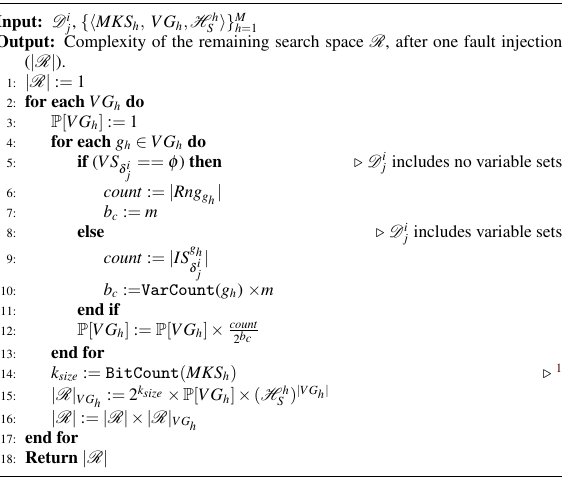
Algorithm 3 Procedure EVAL_ SEARCH_ SPACE